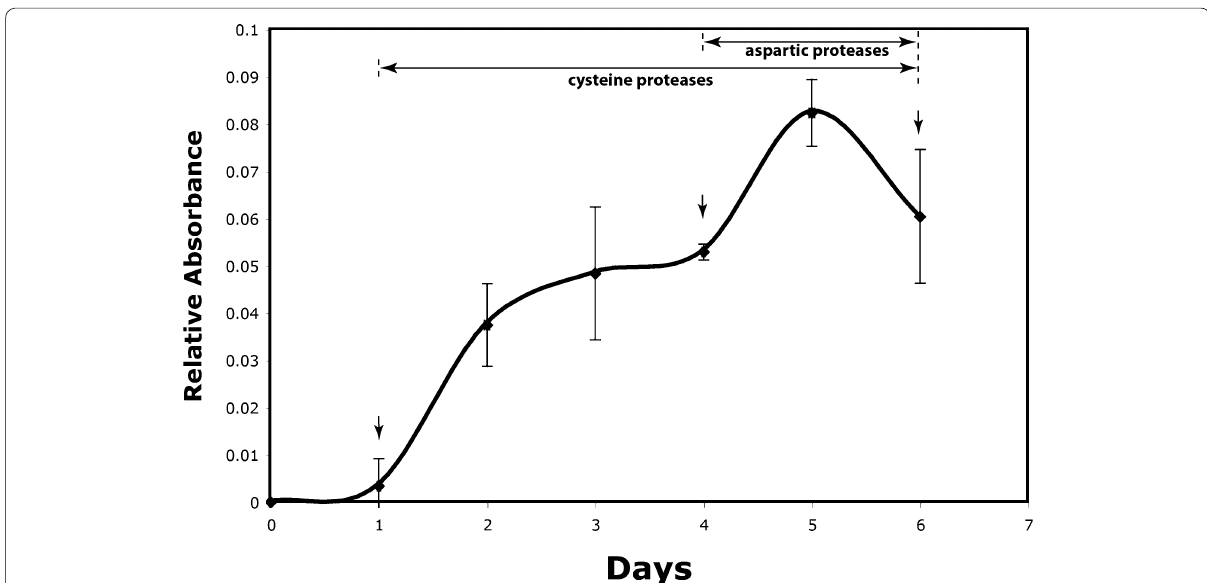
Fig. 2 Changes in secreted protease activities after BSA stimulation of the secretory glands (fluorescent casein assay). Arrows indicate the time points where electron tomographic analysis was performed on stimulated samples. Note the biphasic nature of the secretory process. The type of proteases was determined using zymographs. Most traps reopened 7–10 days after